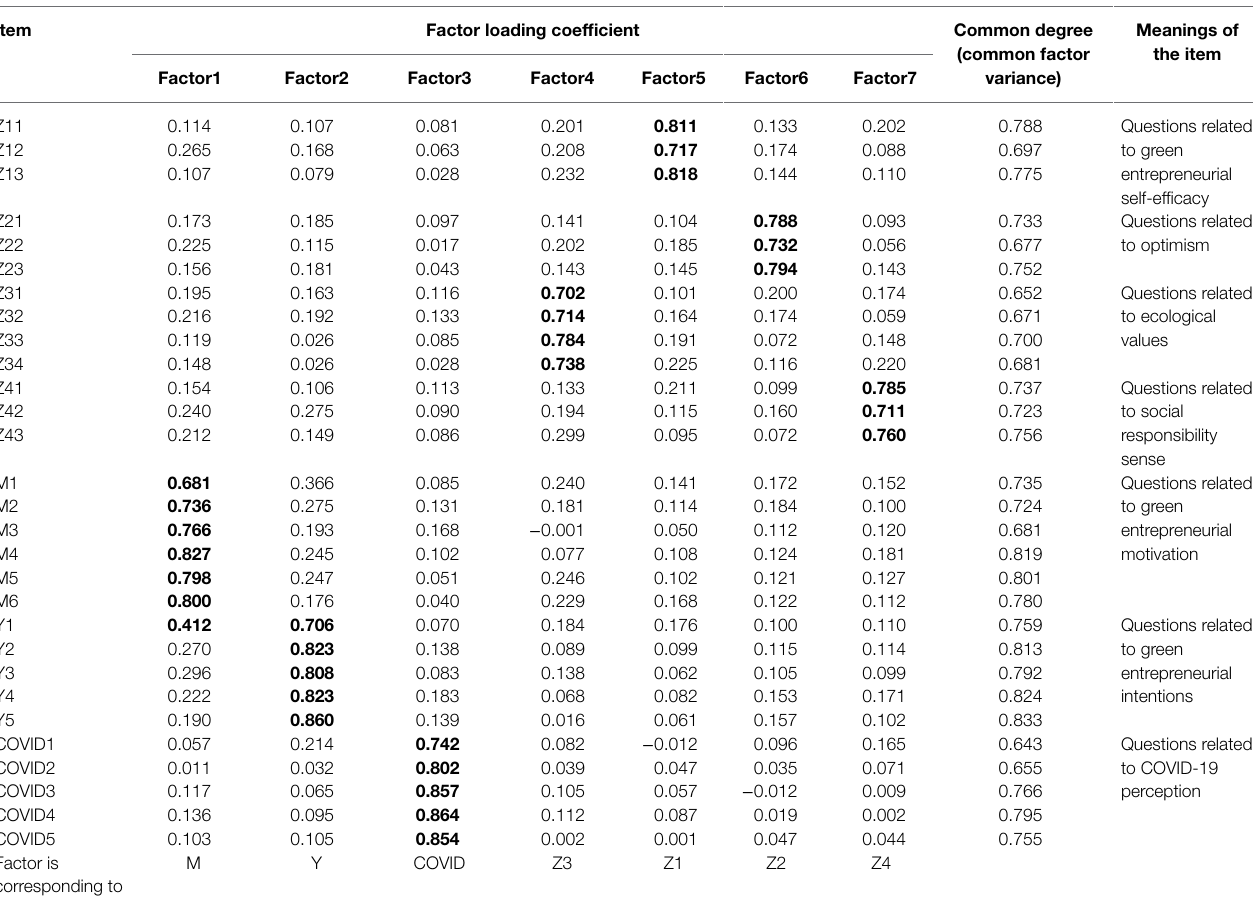
TABLE 3 | Factor loading coefficient and variance interpretation